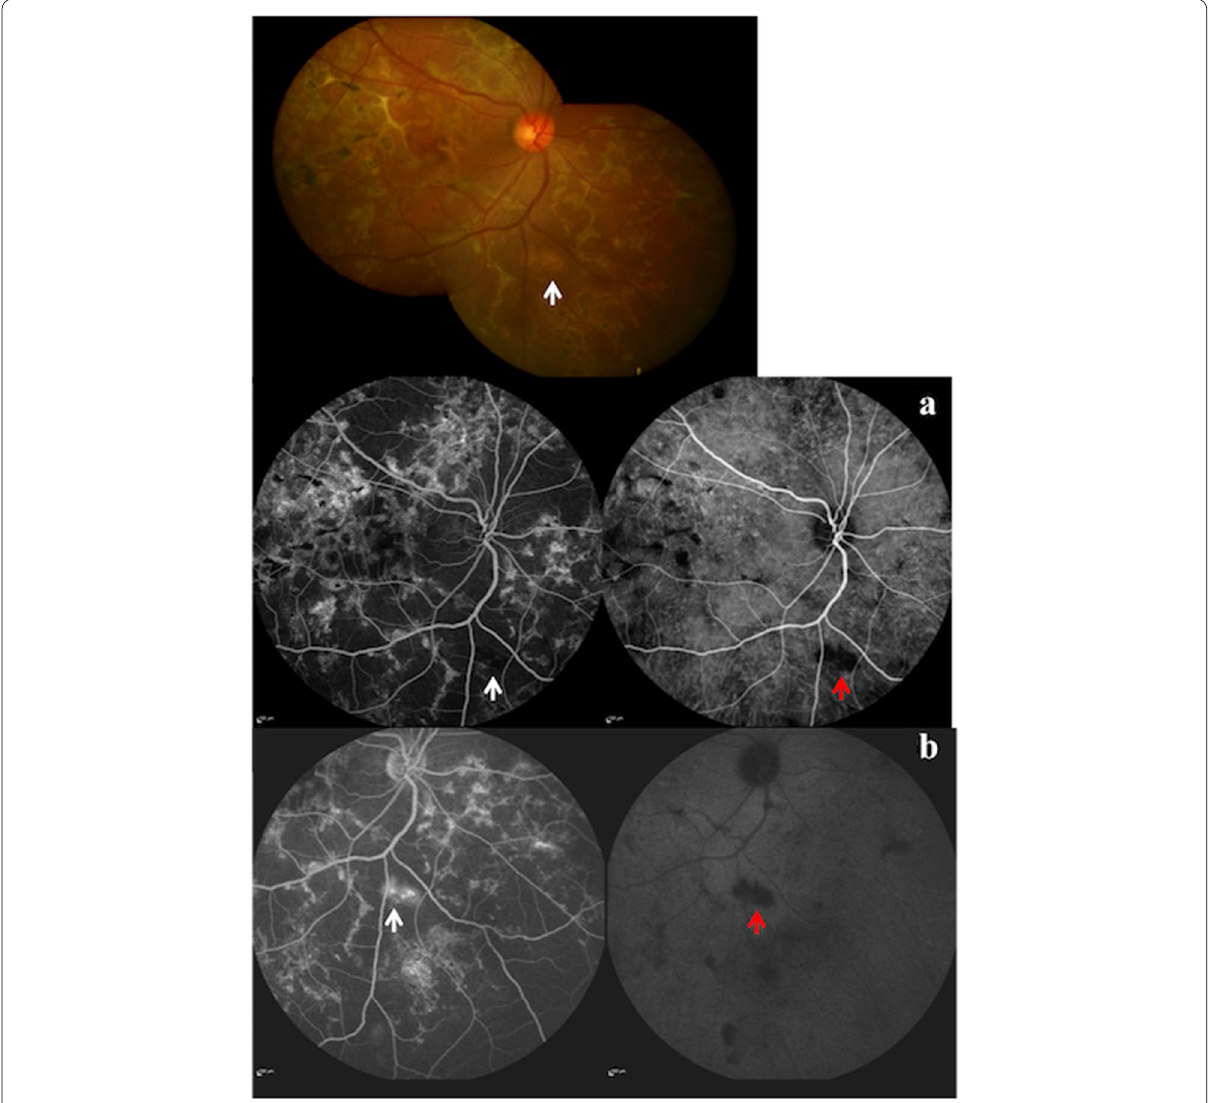
Fig. 3 Color fundus photograph showing predominantly healed lesions of TB SLC (top panel) and a few subtle active lesions (white arrow). Combined fluorescein and indocyanine green angiography in early phase a shows hypofluorescence (white arrow) and hypocyanescence (red arrow) along the active lesion. Late phase b shows hyperfluorescence (white arrow) and persisting hypocyanescence (red